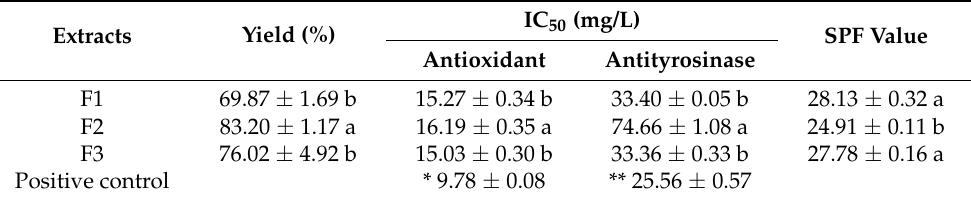
Table 4. Yield, antioxidant, antityrosinase, and SPF value of phytosome-E50.